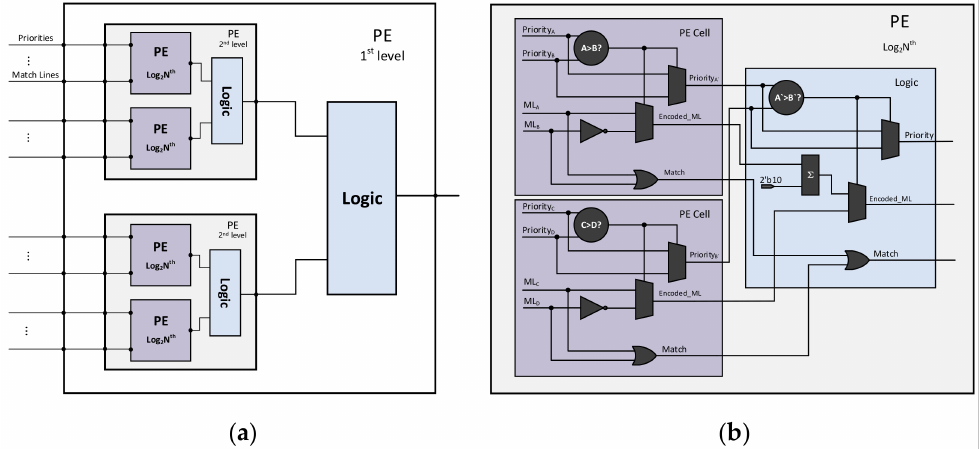
Figure 13. Design of the recursive-style PE. ( a ) Design overview of PE; ( b ) design of the log 2 N th level PE.